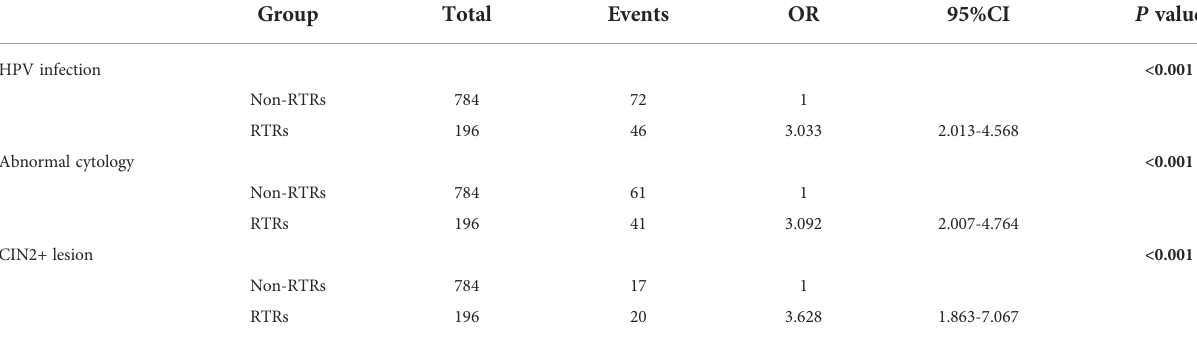
TABLE 2 Odds ratio (OR) of HPV infection, abnormal cytology and cervical intraepithelial neoplasia in Chinese RTRs compared to those in a comparison cohort (non-RTRs). Group